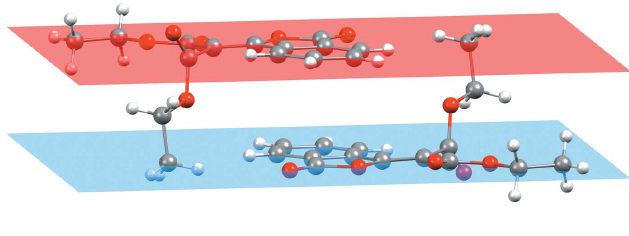
Figure 3 Molecules of ( I ) interacting via parallel-displaced (cid:2) – (cid:2)